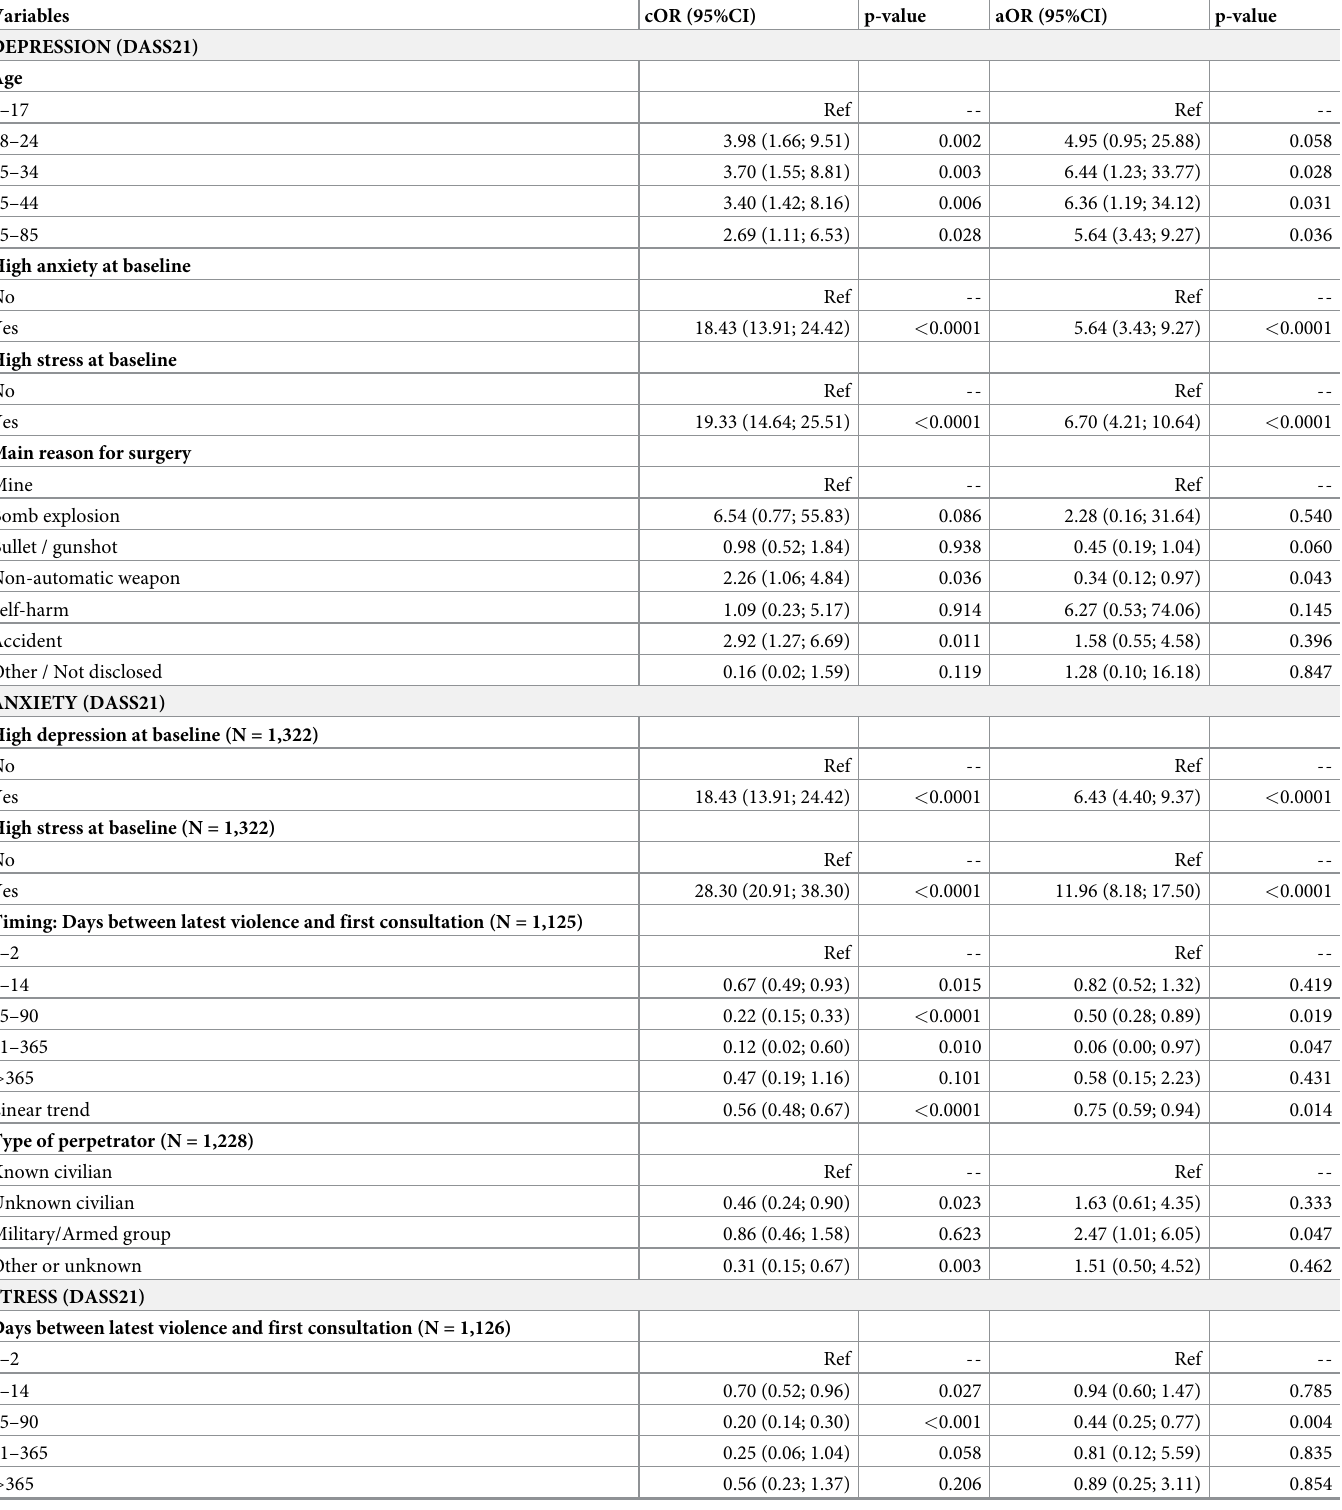
Table 4. Factors associated with high distress and low functioning at